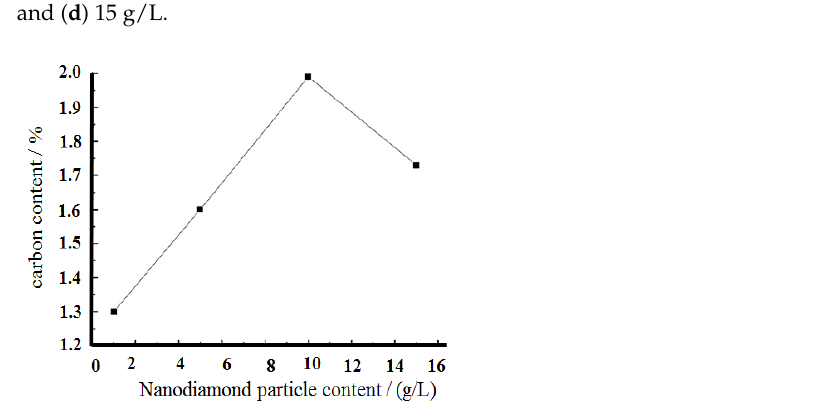
Figure 7. Nanodiamond concentration in the plating solution versus the elemental C content of the prepared composite layer.